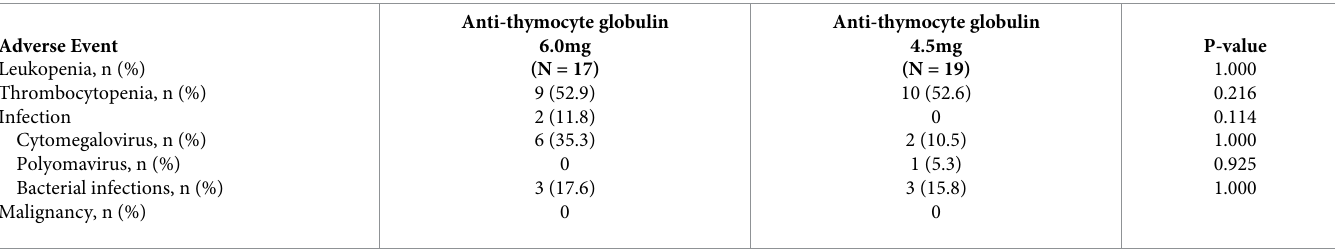
in the ATG6.0 group. There were no cases of malignancy in both groups during the follow-up period.